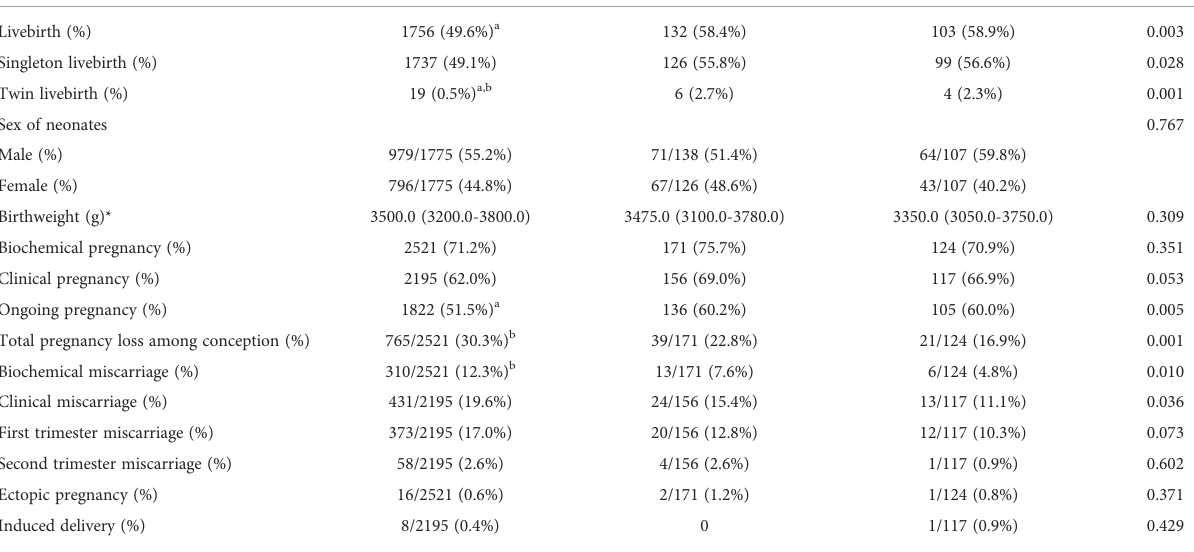
TABLE 2 Reproductive and neonatal outcomes after FET according to the type of endometrial preparation treatments. Characteristic